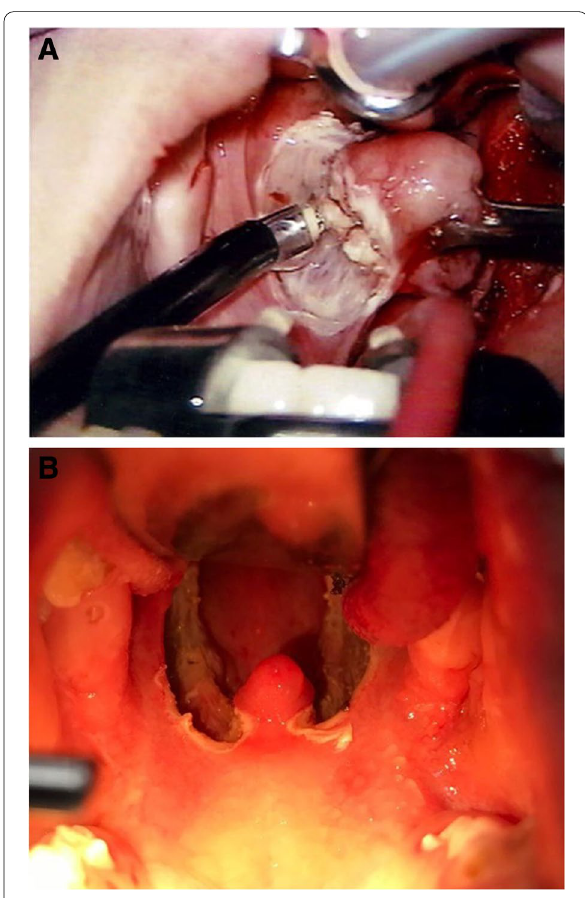
Fig. 1 A Intraoperative image of coblation tonsillectomy. B Immediate postoperative image of the surgical bed in coblation tonsillectomy